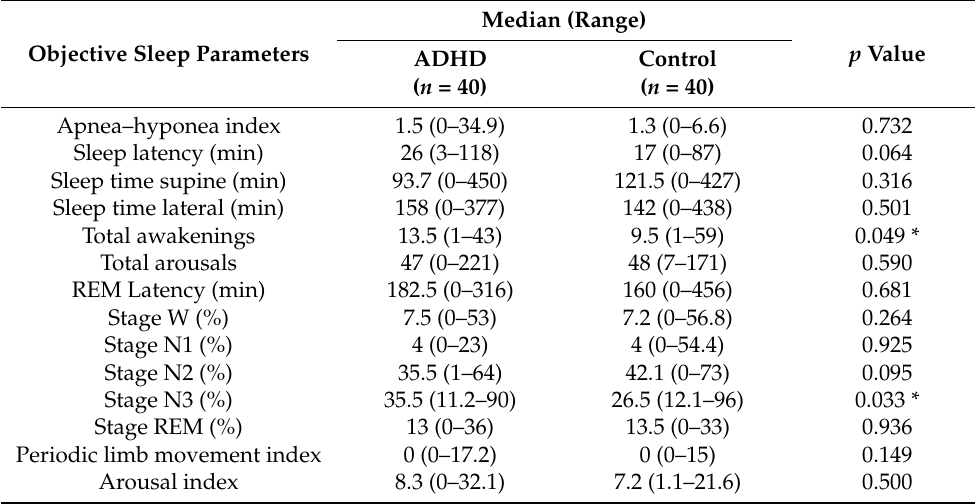
Table 10. Comparison of objective sleep parameters (using polysomnography) between ADHD group and controls.